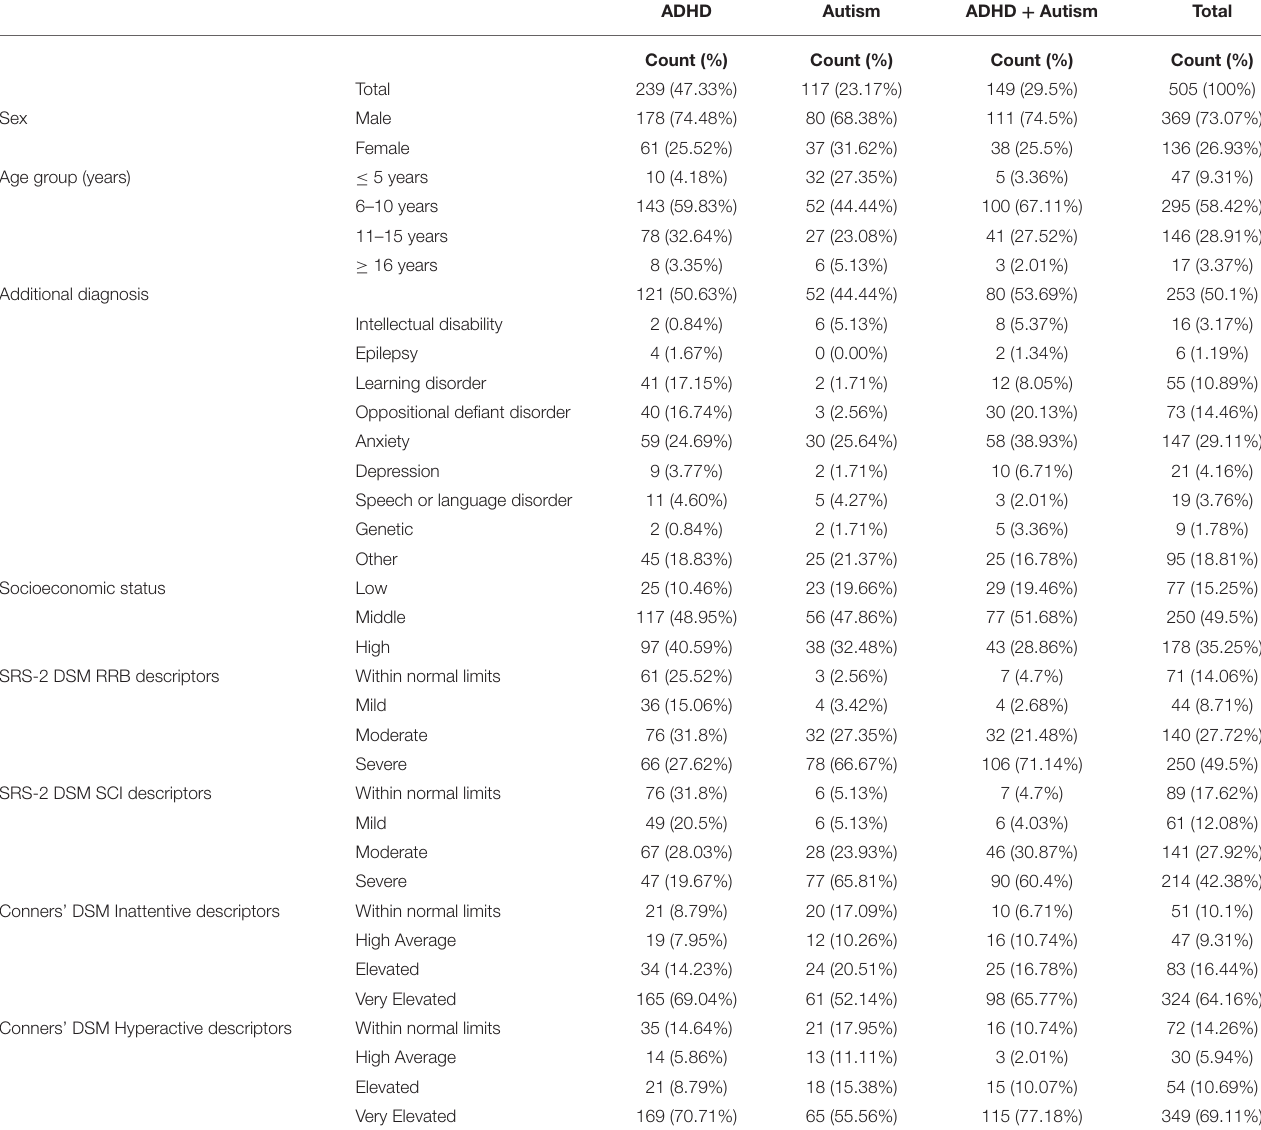
TABLE 2 | Clinical and socio-demographic